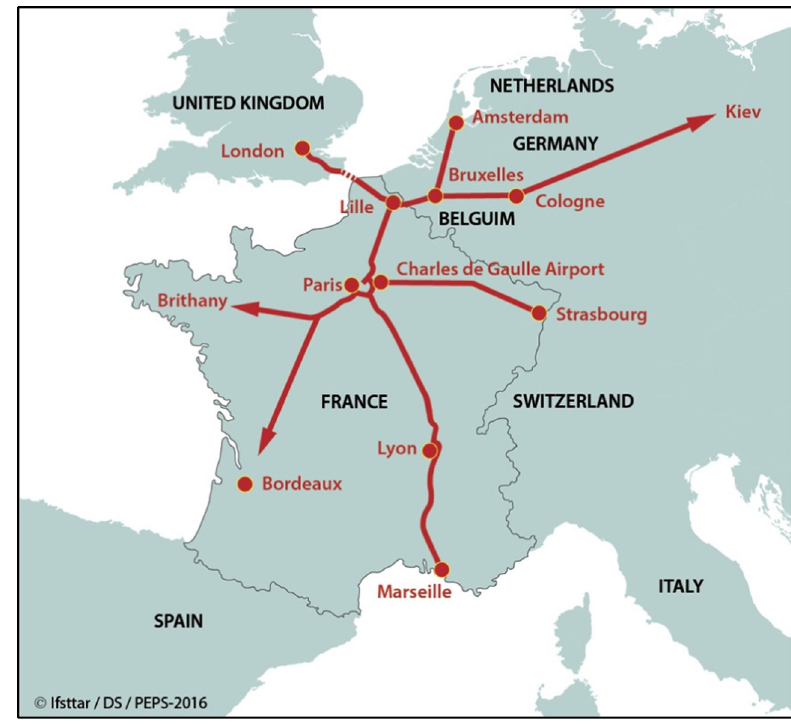
Fig. 2 Place of the B Euraflandres ^ interchange in Lille within the French and international railway network.